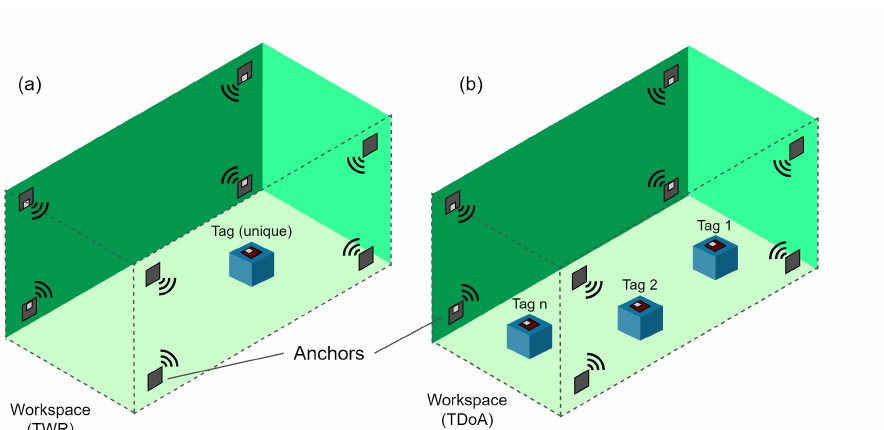
Figure 4. Different configurations of the absolute positioning system mounted within a workspace: ( a ) existence of only one tag: a location algorithm based on “two way ranging” TWR is used. ( b )Two or more tags are present: a location algorithm based on “time difference of arrival” TDoA is used.